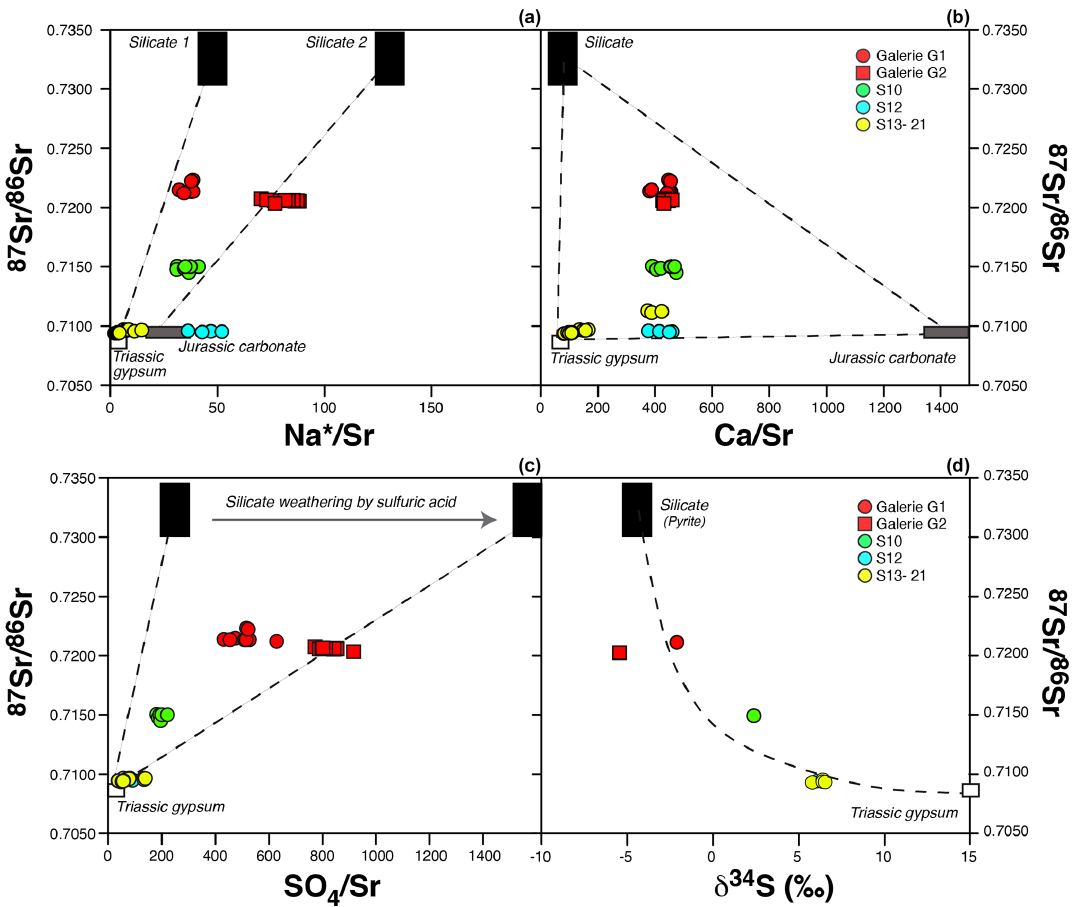
Figure 4. Sr isotopic composition of the different groups of water outflows from the Séchilienne massif as a function of Sr-normalized ratios (a, b, c) and S isotopic composition (d) . Mixing end members are discussed in the text. Straight lines indicate a mixing process in panels (a) , (b) and (c) . In panel (d) , the dashed line is a mixing hyperbola calculated based on the composition of the end members ( 87 Sr / 86 Sr, δ 34 S and SO 4 / Sr ratios of the silicate and carbonate end members).